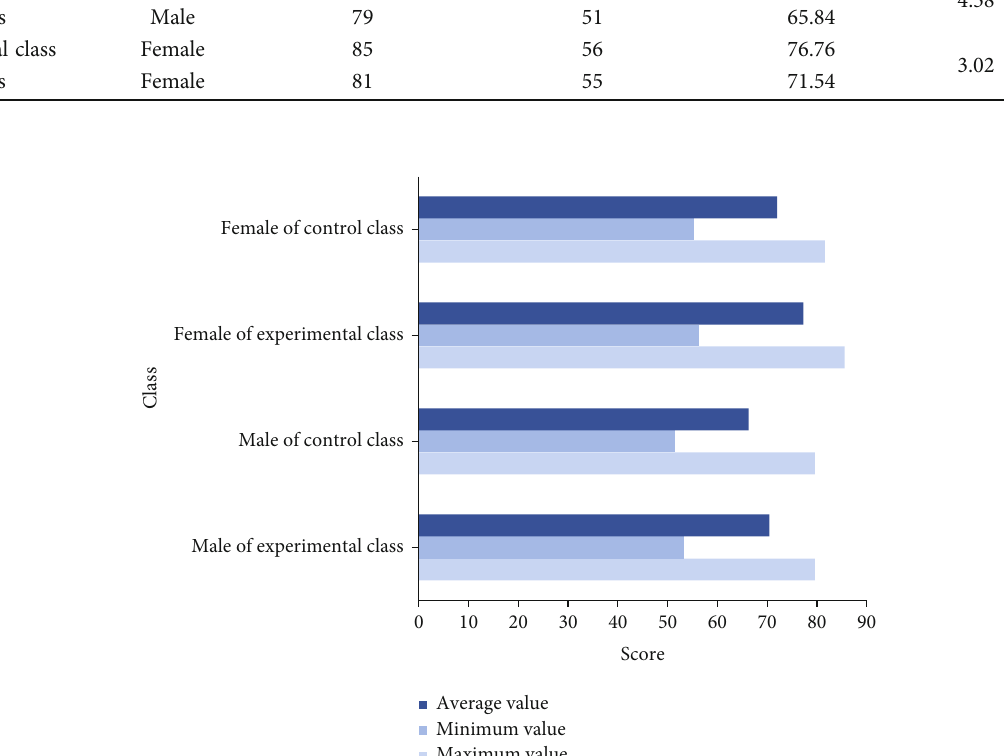
Figure 4: Comparison of the results of aerobics skills test between male and female students in the experimental class and the control